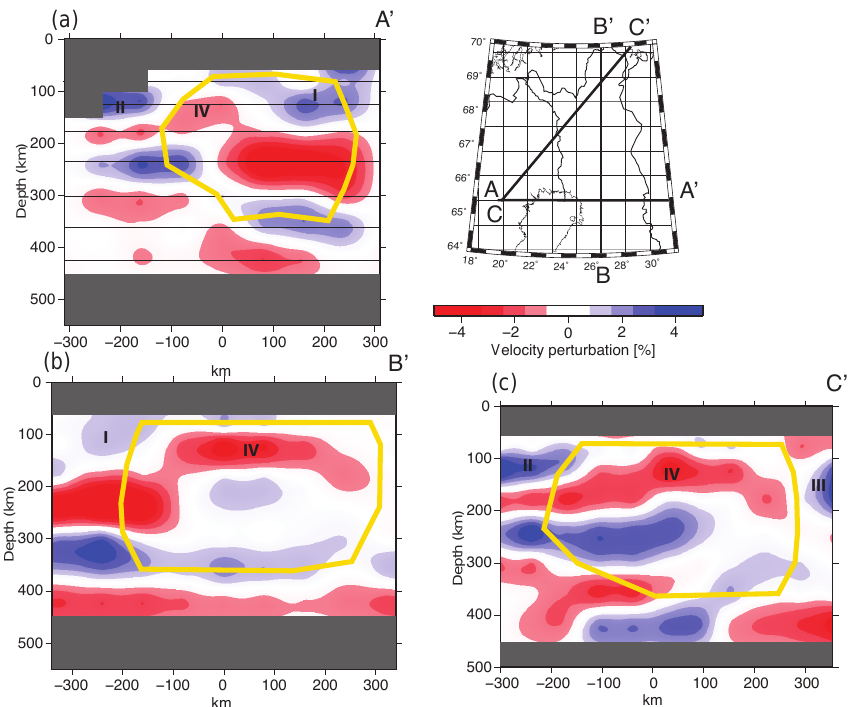
Figure 11. Vertical sections through our final inversion result. The locations of the sections are shown as black lines on the map also showing the horizontal grid. The depth grid is shown in plot of A-A (cid:48) . The areas where no inversion was done are shown in